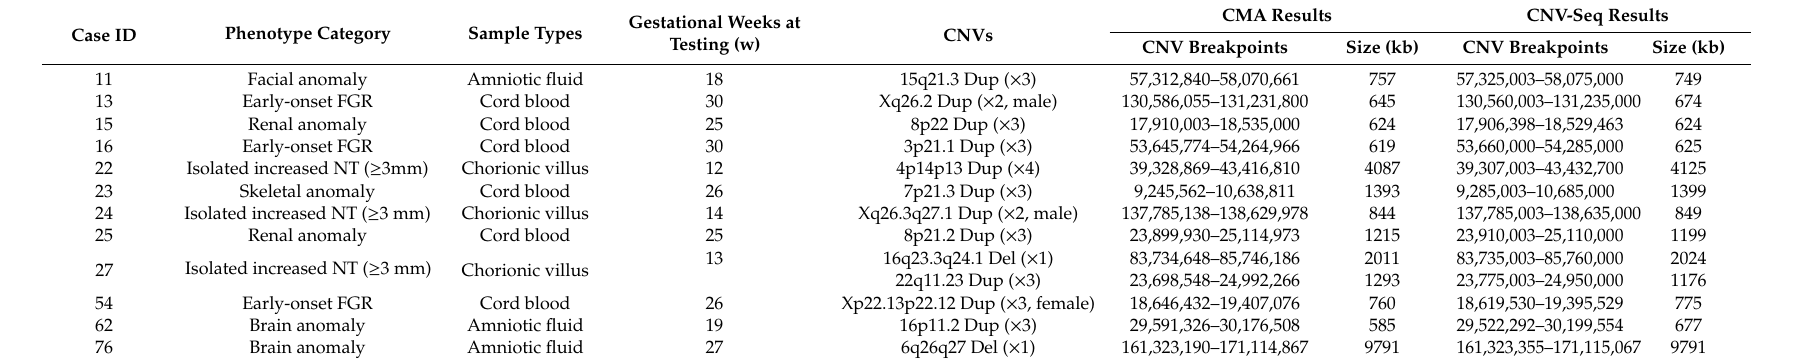
Table 3. Comparison of breakpoints and sizes of CNVs detected by two platforms of CMA and